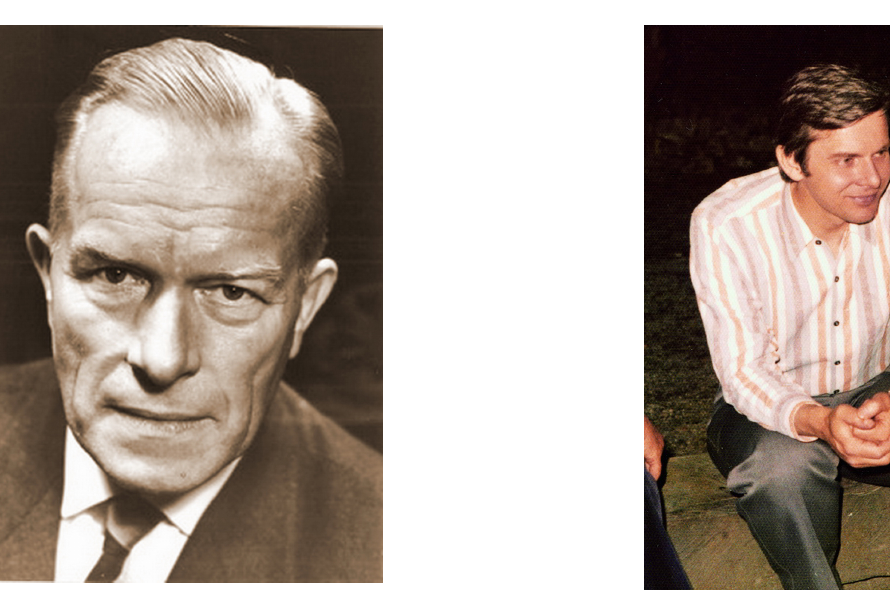
Figure 4. Dr Hans-Jürg Kuhn of the Senckenberg Institute in Frankfurt was appointed to the Senate Commission of the DFG in 1970 (picture from AST Text und Bild).